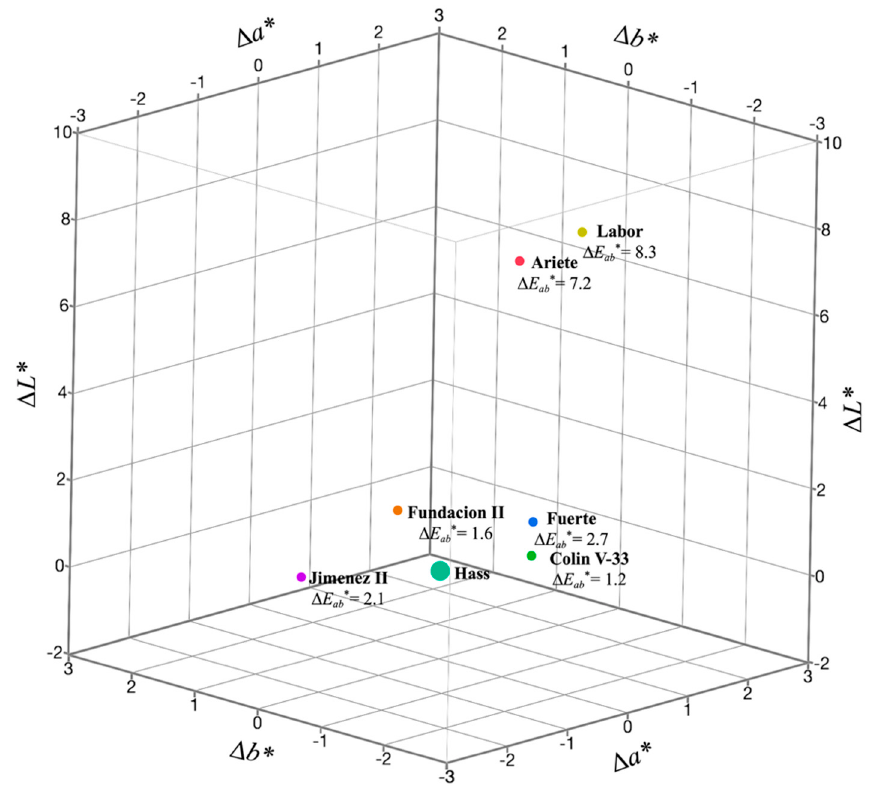
Figure 5. Instrumental colorimetric differences for commercial and non-commercial avocado culti- vars in reference to the widely accepted Hass cultivar. Instrumental data for the Hass cultivar were used as reference control to calculate the deviations of each cultivar for the colorimetric pa- rameters, which included ∆ L *, ∆ a *, ∆ b *, and total color difference ( ∆ E ab